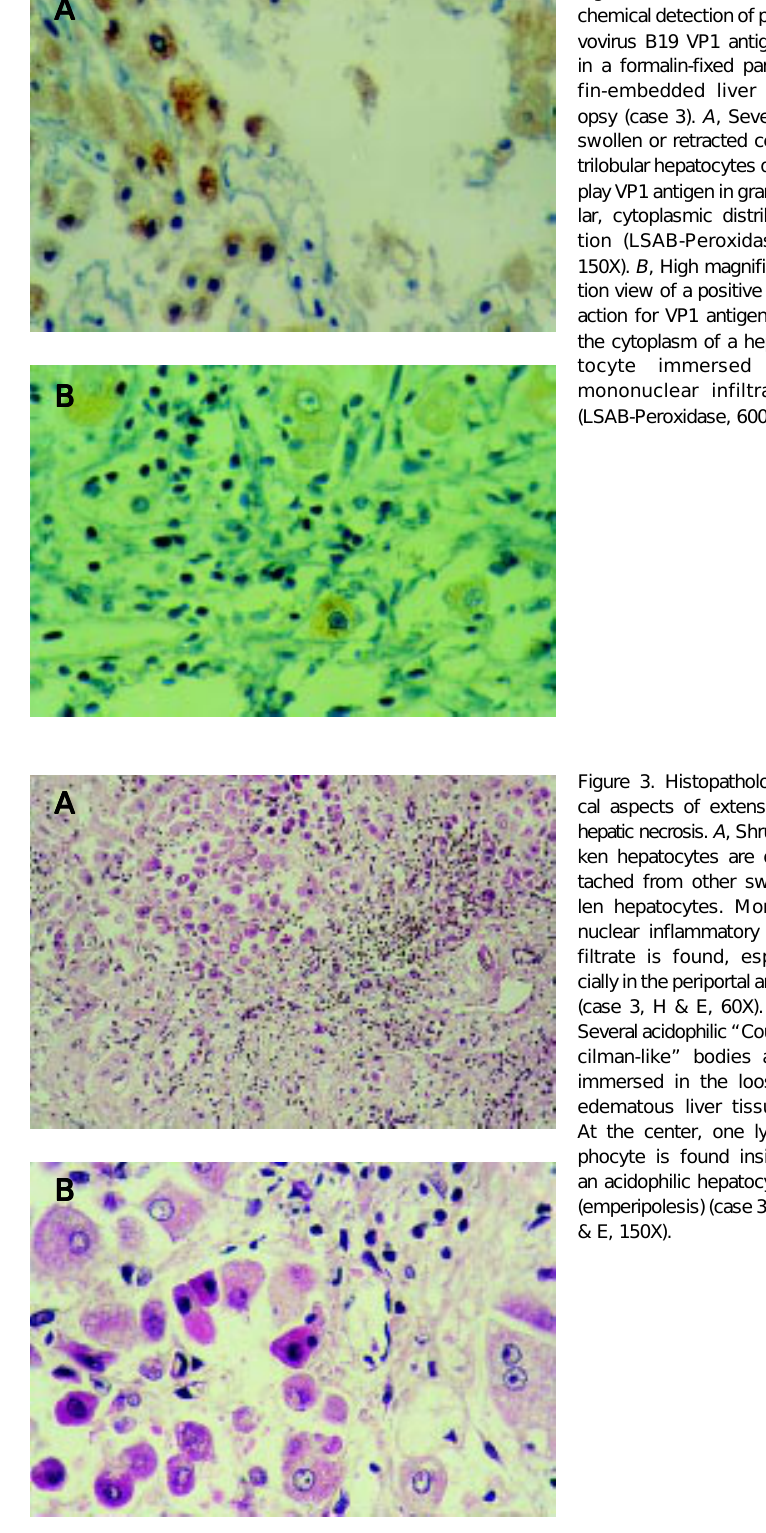
Figure 2. Immunohisto- chemical detection of par- vovirus B19 VP1 antigen in a formalin-fixed paraf- fin-embedded liver bi- opsy (case 3). A , Several swollen or retracted cen- trilobular hepatocytes dis-